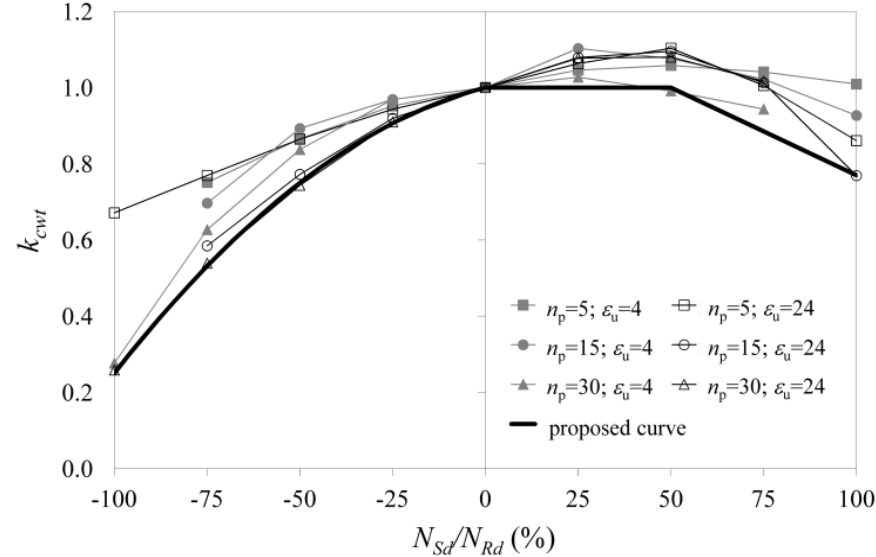
Figure 5. Column web in tension strength–axial load